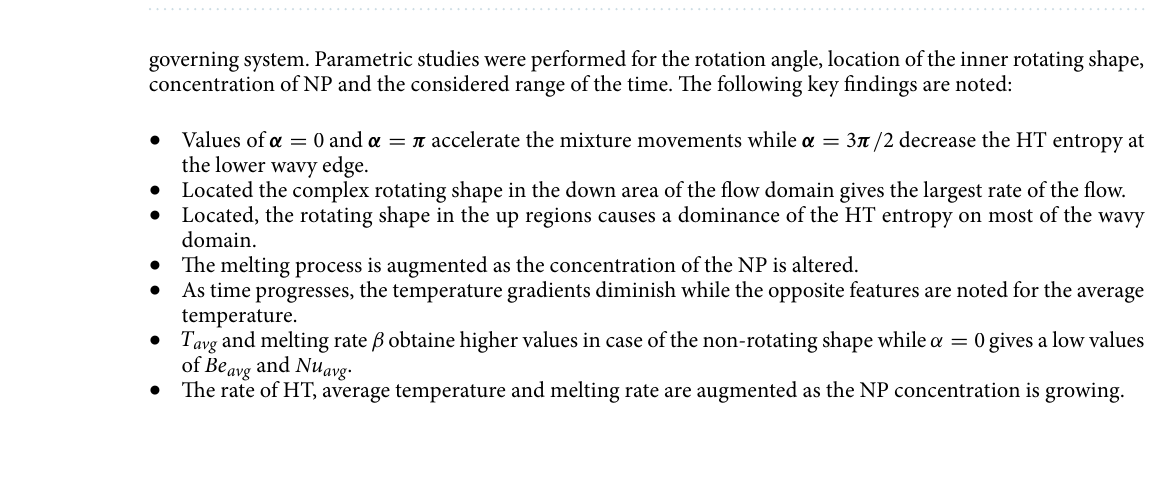
Figure 7. The influence of the rotation angle (α) on the Average temperature, Average Nusselt number, Average liquid fraction (β) and Bejan number over